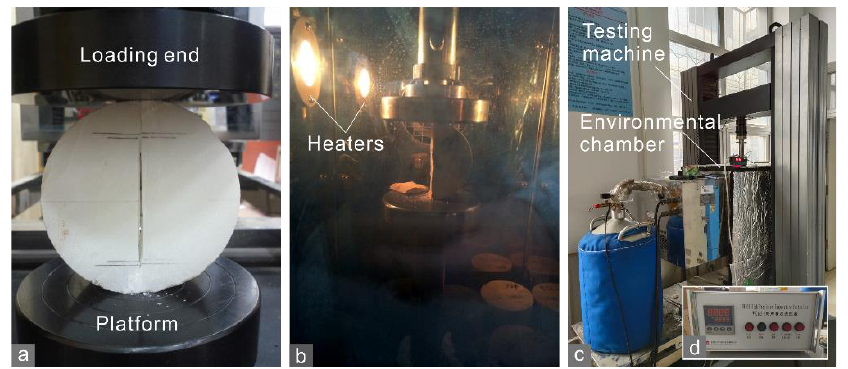
Figure 3. ( a ) CCNBD test on a marble A specimen at room temperature; ( b ) BD test on a sandstone specimen in the chamber at 125 °C; ( c ) MTS servo-control testing machine, SNAS GDS-300 environ- stone specimen in the chamber at 125 ◦ C; ( c ) MTS servo-control testing machine, SNAS GDS-300 mental chamber, and ( d ) WK650 temperature controller. environmental chamber, and ( d ) WK650 temperature